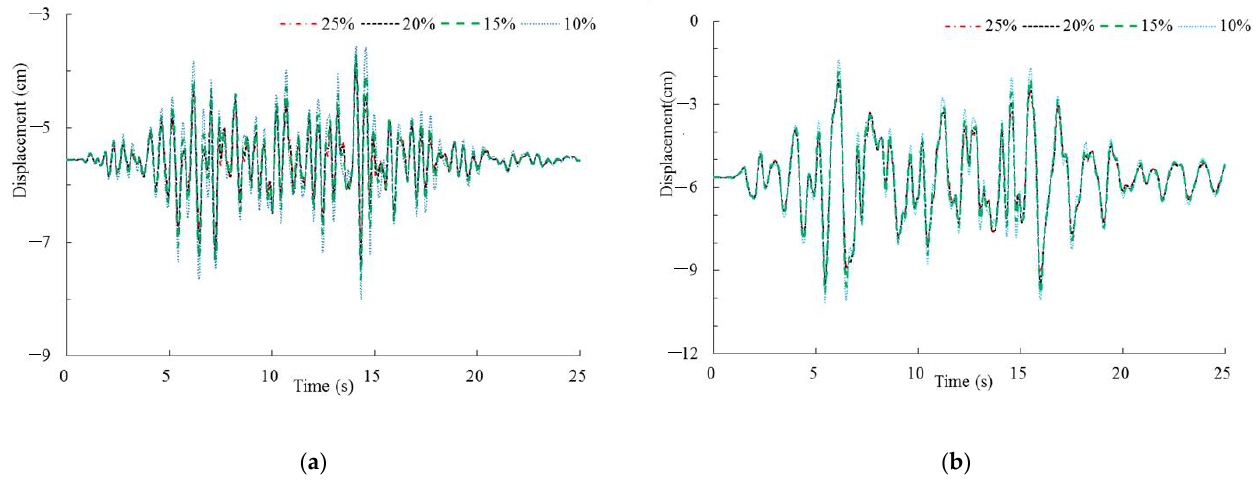
Figure 17. Comparison of the vertical relative displacement response of the center and edge 3D-CIBs. ( a ) At center; ( b ) At